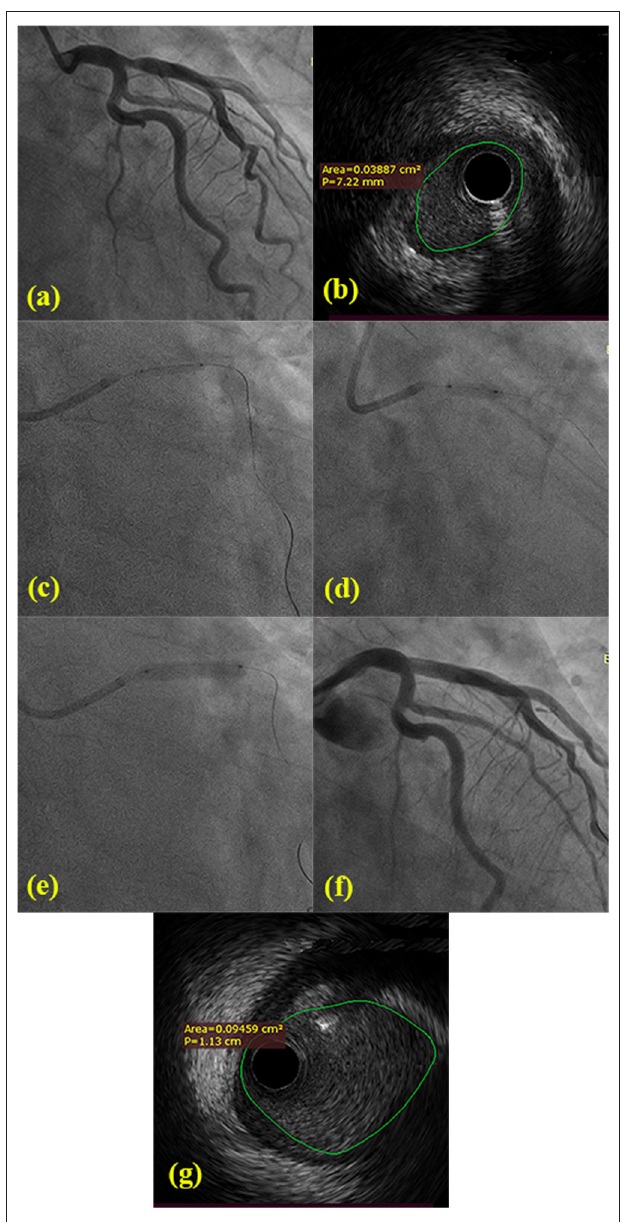
FIGURE 1 | (a) Angiology showing 80% ostial stenosis of LAD and normal LMB and LCX from two different angles. (b) Pre-procedural IVUS confirmed the minimal lumen area of LAD ostial lesions. (c) The 2.0mm × 15mm balloon was pre-dilated at LAD ostial lesions. (d) The 3.0mm × 10mm cutting balloon was repeatedly predilated at LAD ostial lesions. (e) The 3.5mm × 20mm DCB was dilated with 7 atm × 60s. (f) The post-procedural angiology showing significant stenosis decreasing. (g) Post-procedural IVUS confirmed the minimal lumen area and the extent of dissection following DCB-only.